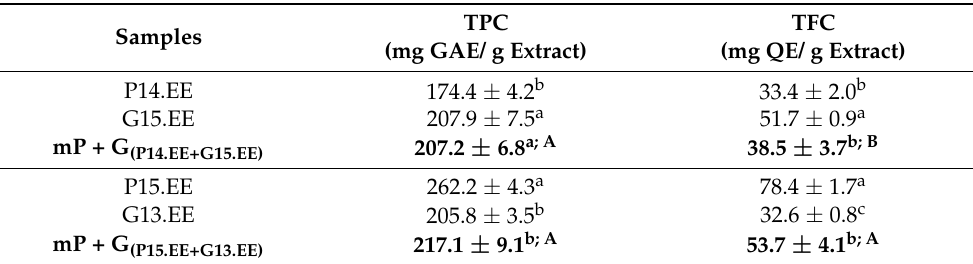
Table 5. Total polyphenols and flavonoids contents of the mixtures prepared with ethanol extracts of propolis from Pereiro and from Ger ê s, considering the most and the least active extract with regard to its antioxidant activity. The TPC and TFC of each EE are included for ease of analysis. The results are presented as mean ± standard deviation of mg of gallic acid equivalents per g of extract (mg GAE/ g extract) and mg of quercetin equivalents per g extract (mg QE/ g extract) for the TPC and TFC, respectively. Significant differences between single EEs (P and G) and mixtures (mP + G) ( p < 0.05) are noted with different lowercase letters. Significant differences ( p < 0.05) between mP + G are represented with different uppercase letters.